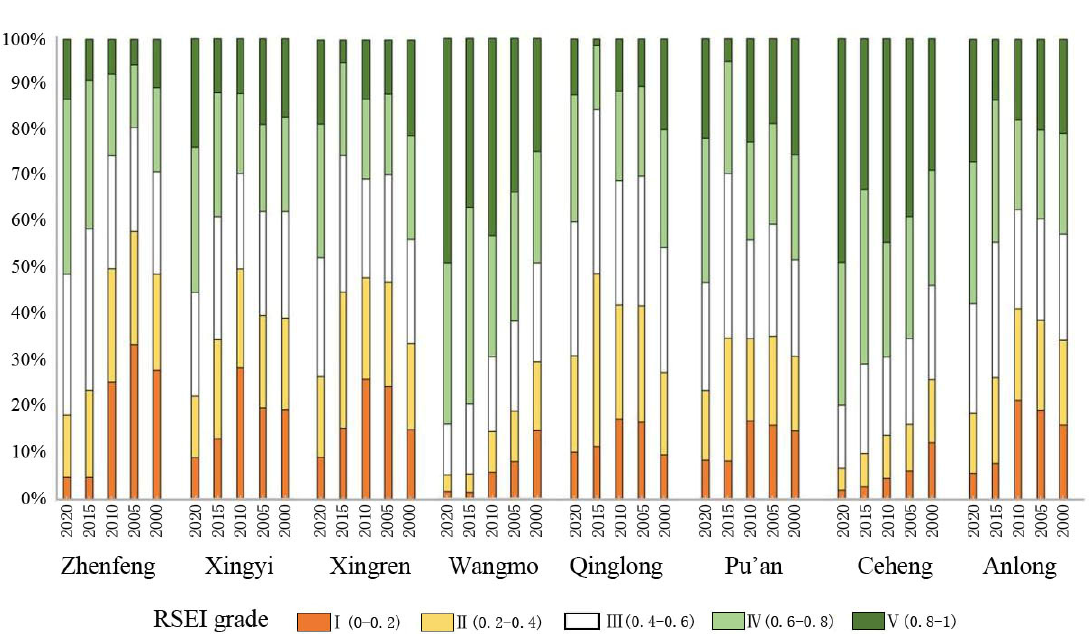
Figure 4. Eco-environment quality dynamics by classified RSEI of the counties from 2000 to 2020. During the period 2010–2015, the proportion of EEQ attributable to poor and relatively poor grades decreased to 26.26%, which originated from areas mainly concentrated in north-central Xingren, south-central Pu’an, north-central Xinyi, and other regions. The proportion of excellent and good grades rose to 48.46%, which was attributable to the areas that were concentrated in the southeastern area of Ceheng and Wangmo. During this period, the EEQ grade remained the same in an area accounting for 42.48% of the total study area. The area that saw an EEQ reduction accounted for 24.80% of the study area. This area with reduced EEQ was mainly distributed in Wangmu, Ceheng, Pu’an, and Qinglong. In this period, the dominant EEQ grades were excellent and good (Figures 4 and A1, Table 1). Table 1. The transition matrix of EEQ levels during 2010–2015. EEQ level